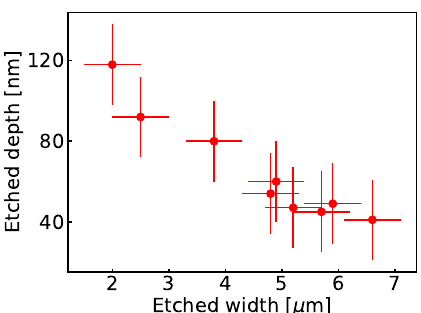
Figure 3. A dependence of the depth of etched grooves on their width at a constant time of etching equal to 60 s. Error bars show uncertainity given by measurements with the AFM.